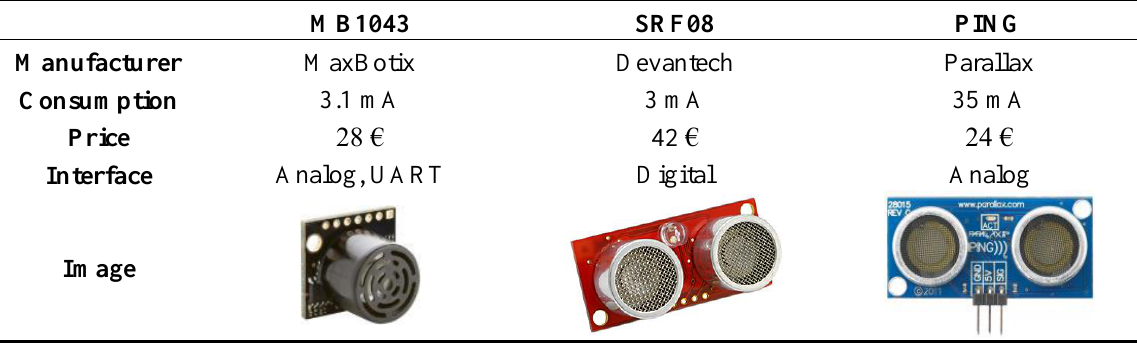
Table 4. Technical features of the evaluated distance